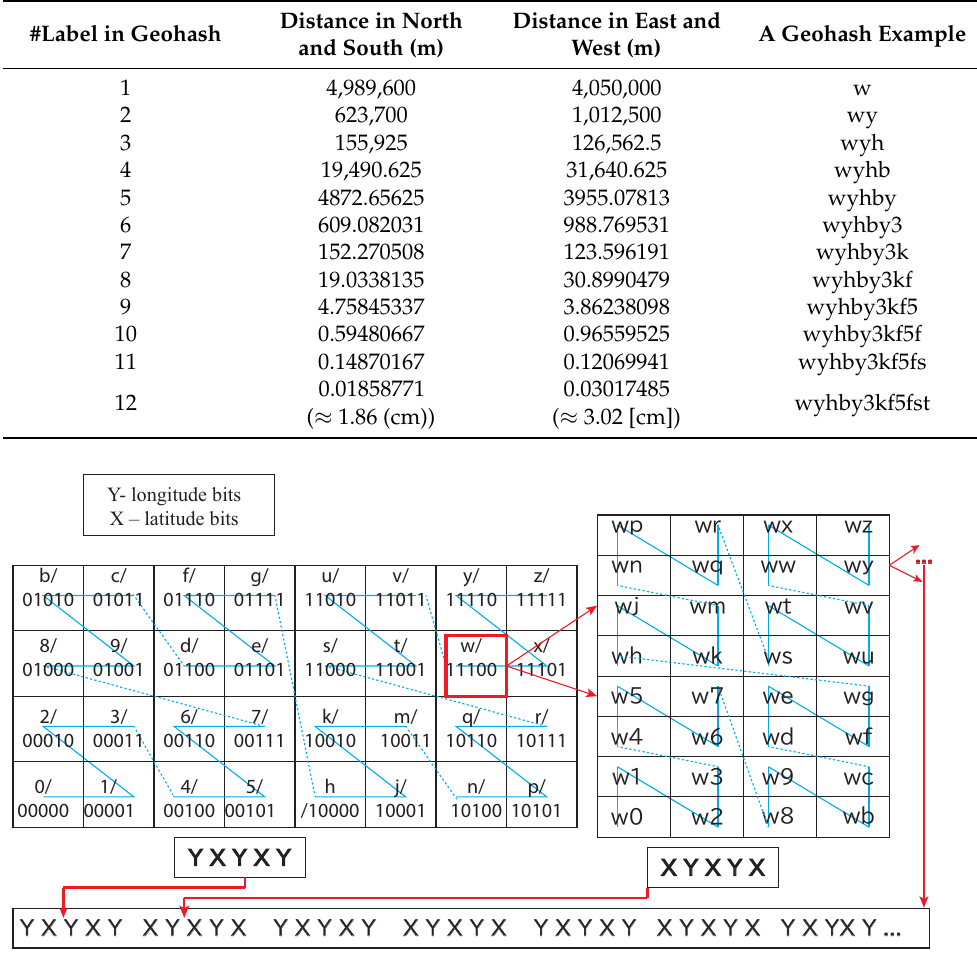
Figure 1. Geohash follows an alternate sequence of space-filling curves. Characters binary represen- tation determining latitude X bits and longitude Y bits cross bit by